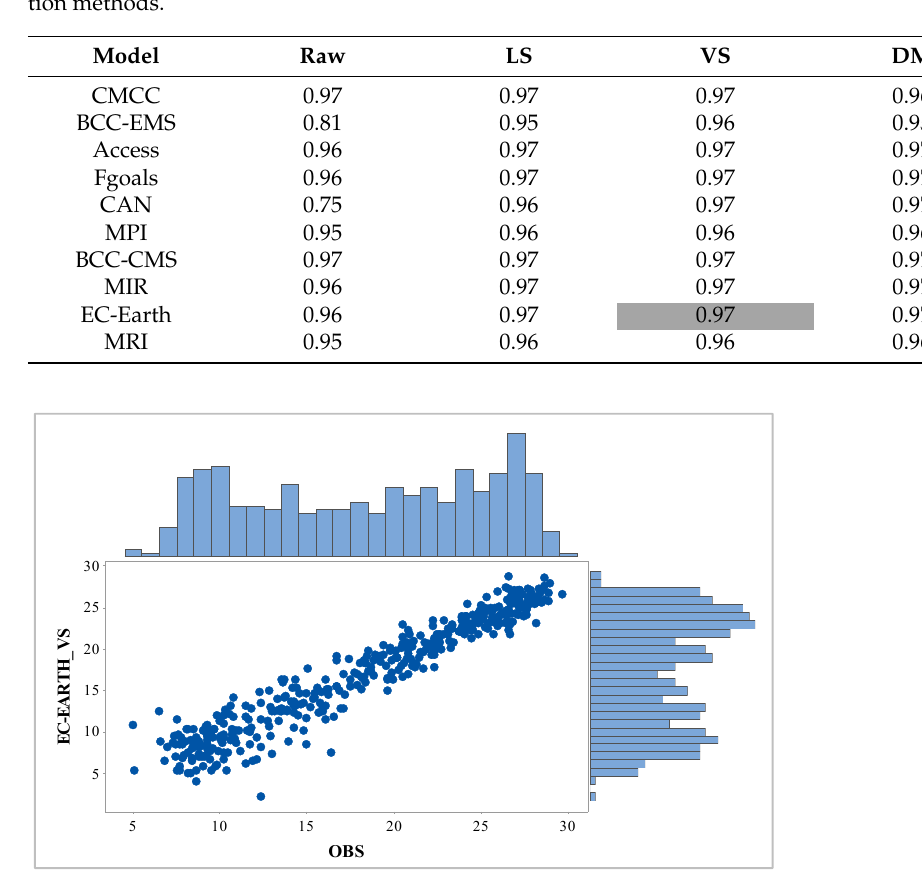
Figure 3. Marginal plot between reference temperature monthly time series (OBS) and EC-Earth with variance scaling.